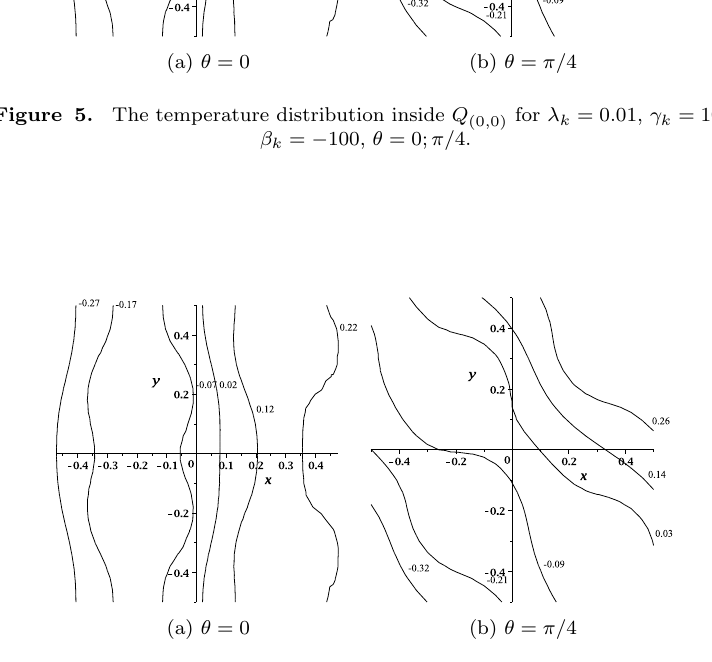
The values of all components of the tensor Λ e as a function on the radius R are presented in Tables 3-6 for different parameters λ k , γ k and β k . The calculations were performed with the found accuracy between five or six valid